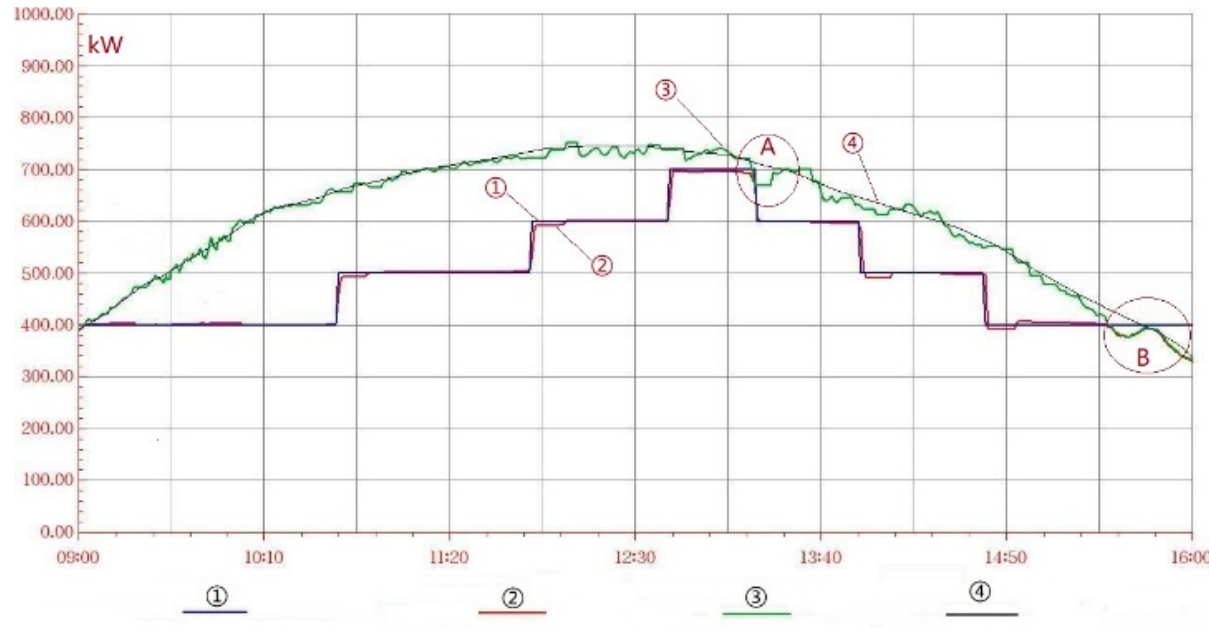
Figure 5. Power curves for the potential maximum power capability (PMPC) and the real power output in a PV subarray.